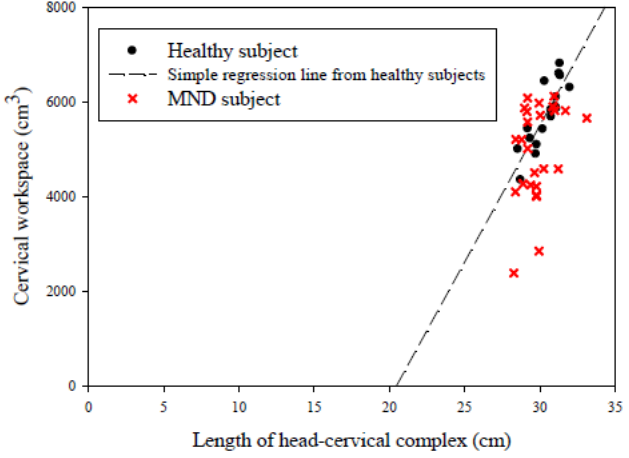
Figure 5. Scatter plot of the cervical workspace versus the length of the head-cervical complex for healthy and MND subjects. The simple linear regression equation obtained from healthy subjects: Cervical workspace (cm 3 ) = 577.13 × (Length of the head-cervical complex) – 11,814.82 (cm) ( R 2 = 0.701, P < 0.01).